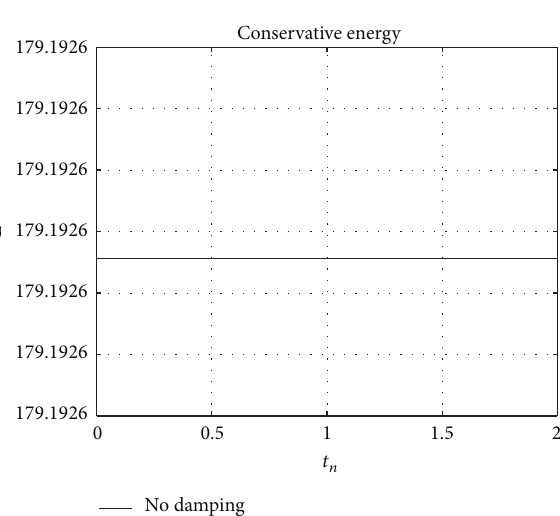
Figure 4: 𝛽 1 = 1 , 𝛽 2 = 0.4 .